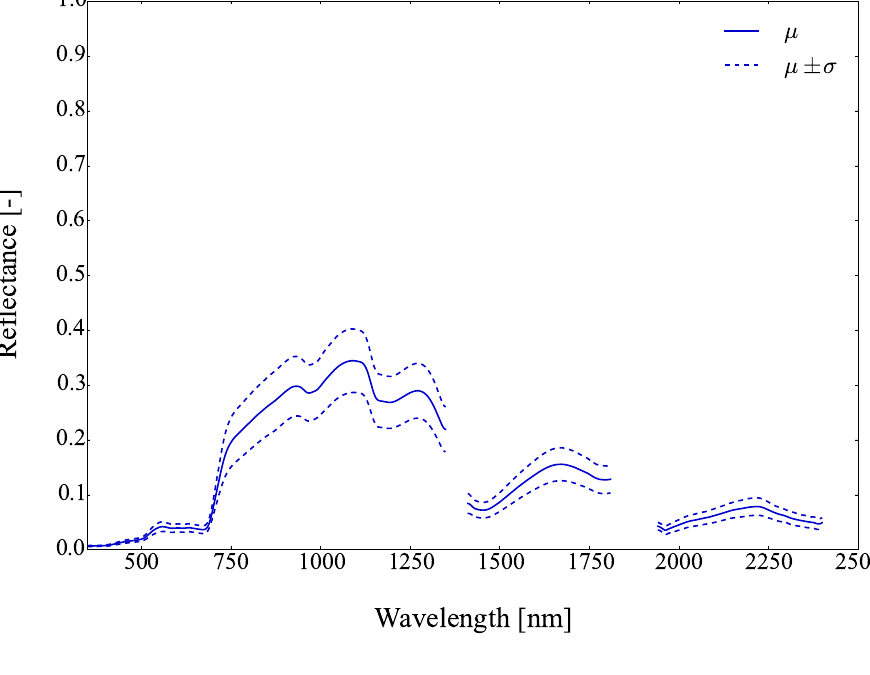
Figure A6. Mean reflectance ( µ ) and standard deviation ( σ ) of Eleocharis quinqueflora